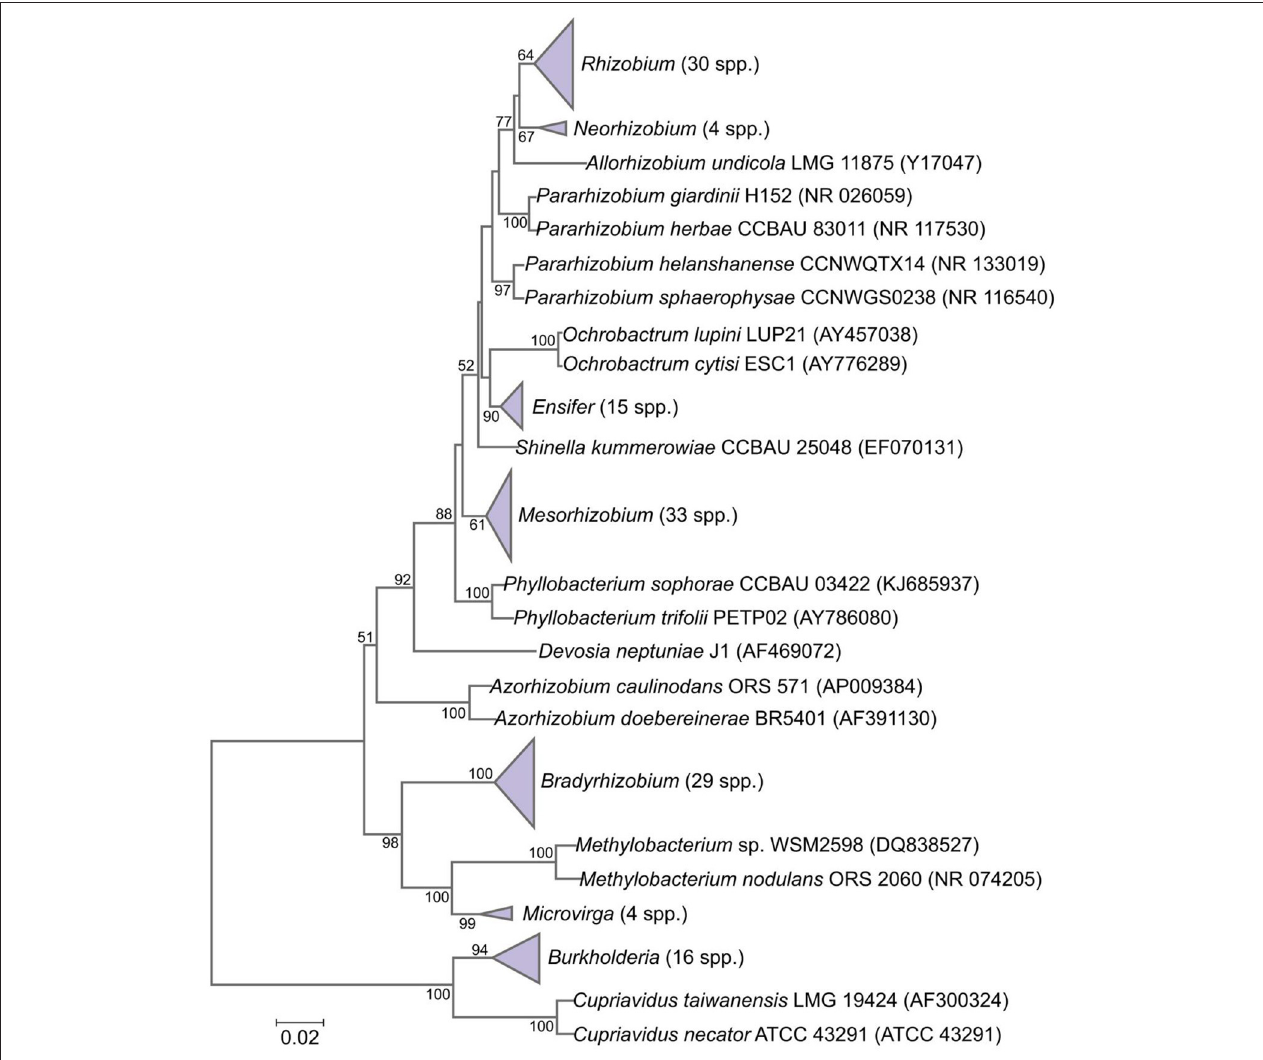
FIGURE 2 | Phylogenetic tree presenting the relationships among currently described genera and species of Alpha- and Beta-rhizobia based on aligned sequences of the 16S rRNA gene (1,341-bp internal region). Adapted from Sprent et al. (2017).